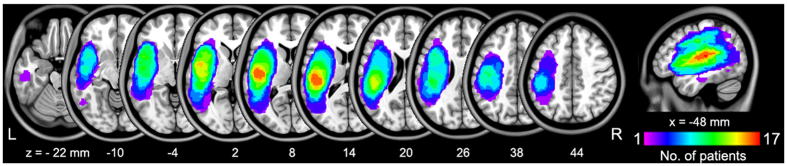
Distribution of the lesion areas for all aphasic patients.The lesion area overlap across patients was rendered on the brain. Colors represent the number of patients with a lesion to a specific voxel. Numbers below each axial map and sagittal map refer to the z-plane and x-plane coordinates of the MNI space, respectively. Letters L and R correspond to the left and right sides of the brain, respectively.